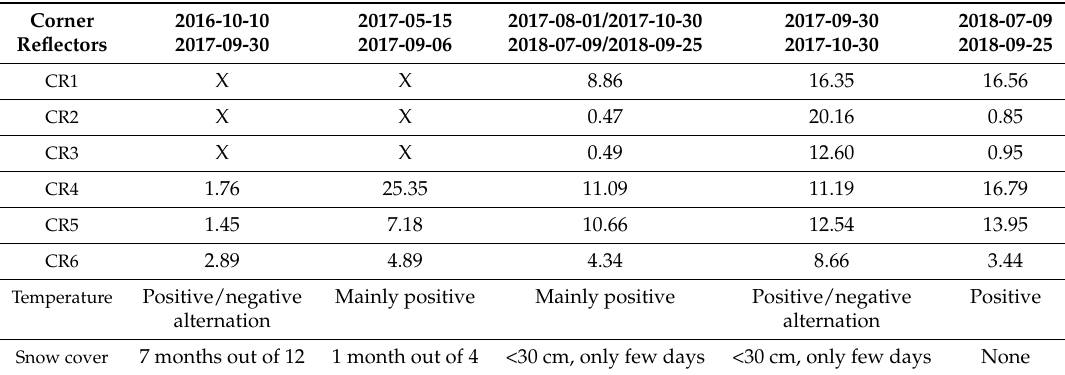
Table 4. Intensity Mean Sigma Ratio (dB) estimated on six CRs between 2016-10-10 and 2018-09-25. Temperature and snow cover information from a weather station of Meteo France (45.97991, 6.89132,